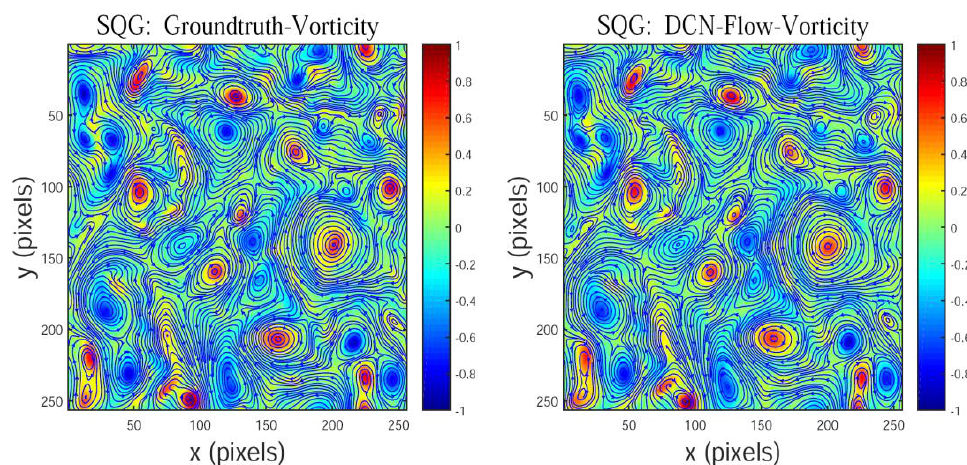
Figure 14. The color-coded vorticity field of SQG estimated by our method (DCN-Flow). Table 1. Evaluation results of different motion estimators on the public fluid datasets.